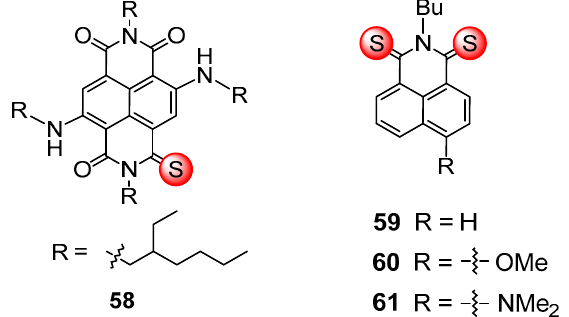
Figure 20. Representative triplet PSs with thionated carbonyl groups.